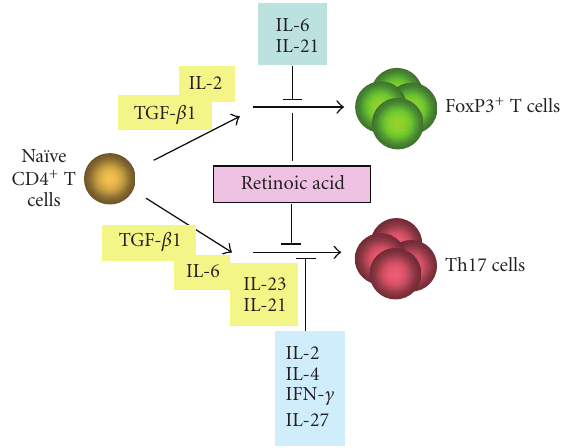
Figure 4: Reciprocal regulation of FoxP3 + T cells and Th17 cells by retinoic acid. IL-2 and TGF- β 1 promote the generation of FoxP3 + T cells from na¨ıve T cells in the periphery, while IL-6 and TGF- β 1 promote the generation of Th17 cells, an inflammatory T cell subset that produces IL-17A, IL-17F, IL-21, and IL-22 as the major e ff ec- tor cytokines. IL-2 and the cytokines that promote T cell prolifer- ation into Th1 or Th2 cells (IL-4, IL-12, IFN- γ , and IL-27) would suppress the generation of Th17 cells, while the pro-Th17 cell cy- tokines, IL-6 and IL-21, can suppress the generation of FoxP3 + T cells. Importantly, retinoic acid suppresses the generation of Th17 cells but promotes the induction of FoxP3 + T